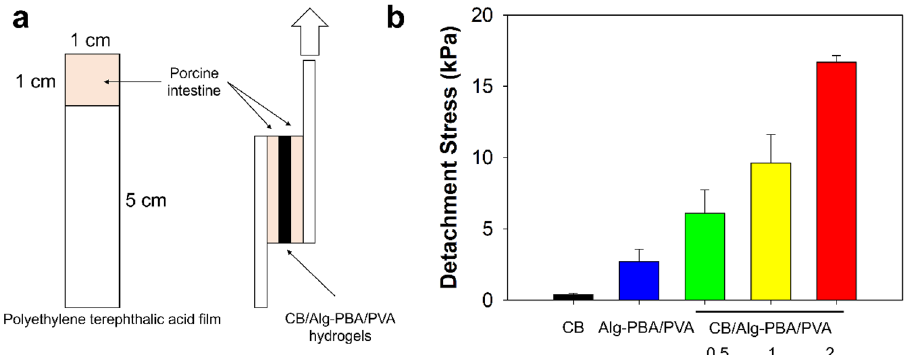
Figure 4. ( a ) Schematic illustrations of the measurements of tissue adhesive property. ( b ) Detachment stress of CB, Alg-PBA/PVA, and CB/Alg-PBA/PVA